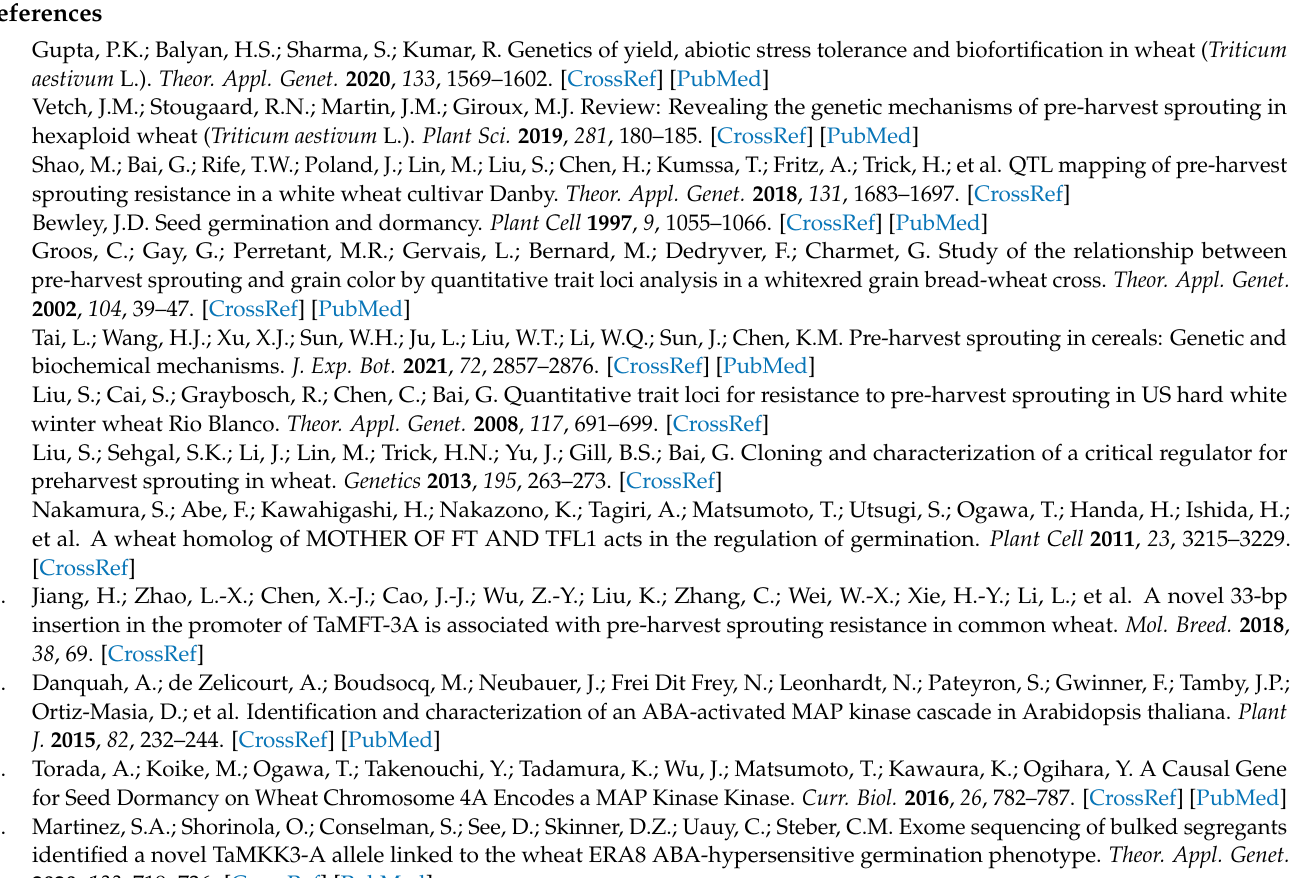
Figure S4: effect of grain color on GI (A) and GP (B) in the YM16/ZM895 double haploid population for all environments; Figure S5: genotyping results for DH parents YM16 and ZM895 with the TaMyb10-A/B/D markers; Figure S6: genotyping results in wheat natural population with the KASP marker for Qdor.hzau-3D.2 ; Table S1: correlation coefficients (r) of GI among all environments in the YM16/ZM895 double haploid population; Table S2: correlation coefficients (r) of GP among all environments in the YM16/ZM895 double haploid population; Table S3: analysis of variance of GI in the YM16/ZM895 double haploid population; Table S4: analysis of variance of GP in the YM16/ZM895 double haploid